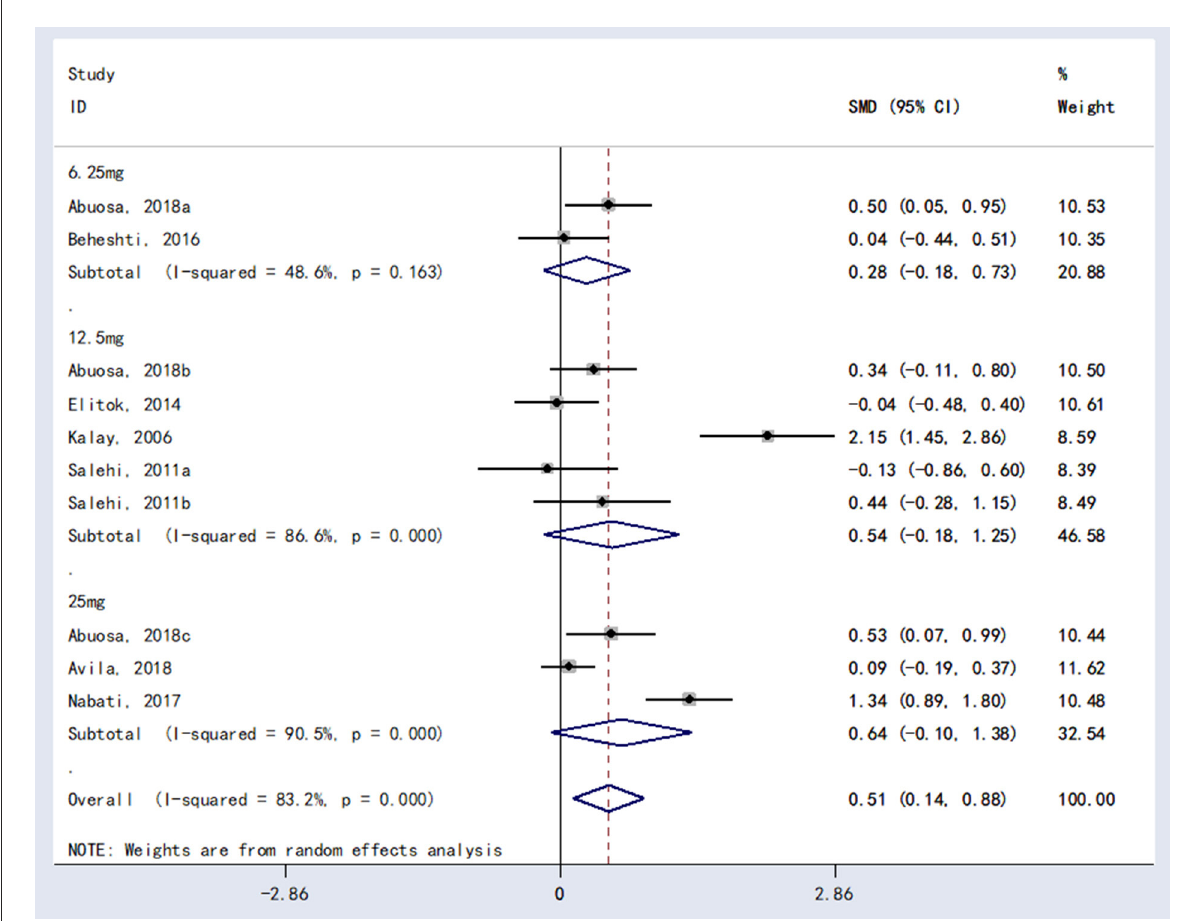
FIGURE5 Subgroup analysis forest plot of effects of different doses of carvedilol on